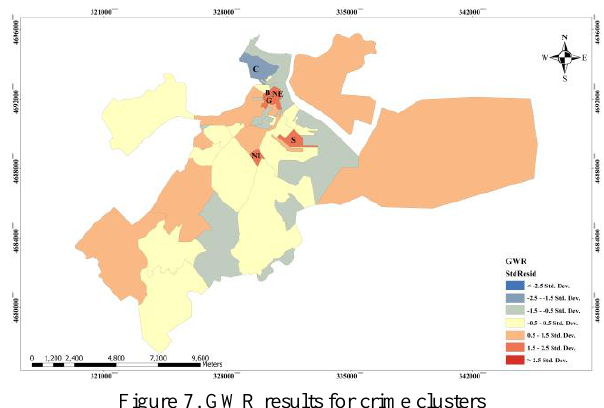
Figure 7. GWR results for crime clusters